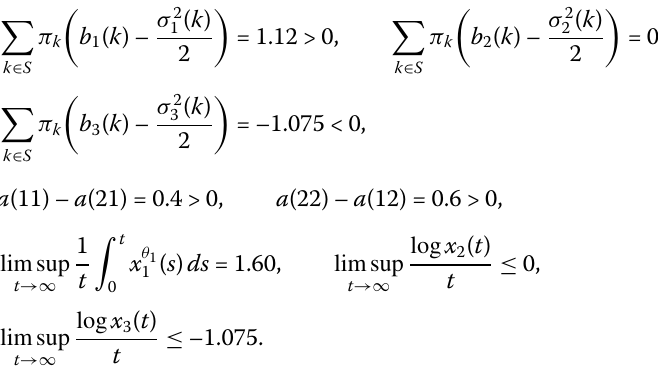
√ σ 2, σ 3 (2) = 2. The initial data x 1 (0) = 0.4 and x 2 (0) = 2 (2) =